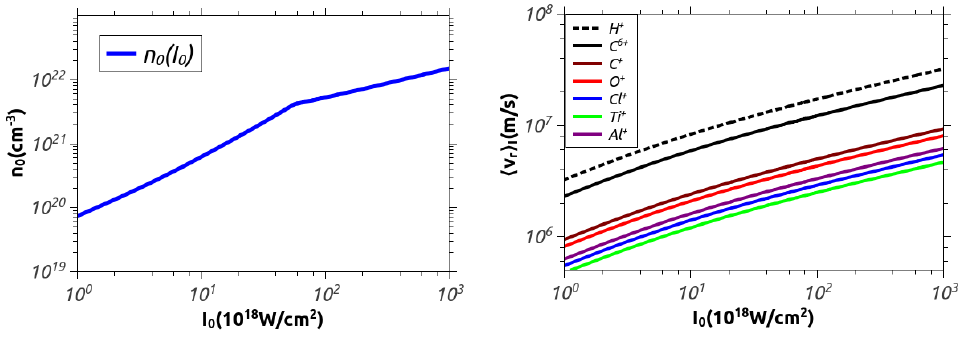
Figure 4. The plots consider the intensity range I 0 = 10 18 − 10 21 W/cm 2 and a laser wavelength λ L = 0.8 µ m, typical of a Ti:Sa laser system. The discontinuity in the subplot ( a ) corresponds to the saturation of conversion efficiency Ω ( I 0 ) = 0.5. In subplot ( b ), low Z metals and typical constituent of organic polymers are considered. Except for the carbon, only first ionization is considered in order to present the lower velocity limit of each